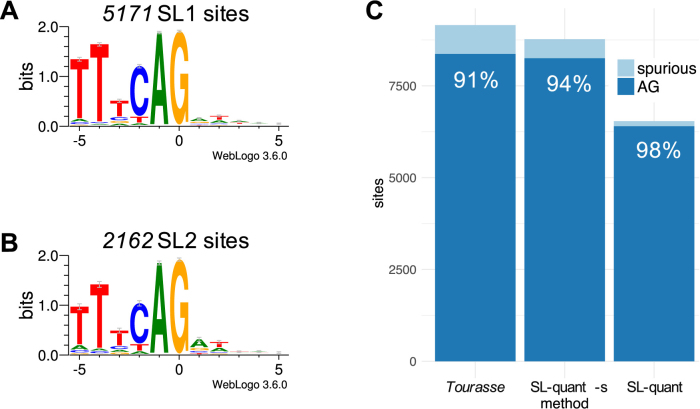
SL-sites consensus sequence. (A) Sequence logo of the sequence environment surrounding SL1 or (B) SL2 trans-splice sites determined by SL-quant on the SRR1585277 dataset in single-end mode. (C) Proportion of AG sequences in SL trans-splice sites identified by SL-quant on the SRR1585277 dataset with the method used in Tourasse et al. 2017 [14] and with SL-quant in single-end mode with or without the sensitive option (-s).